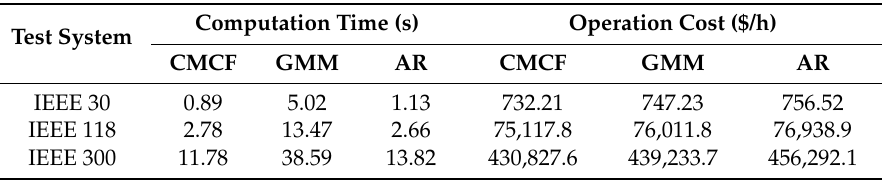
Table 7. Comparison among cumulants and cornish-fisher expansions (CMCF), gaussian mixture model (GMM) and analytical reformulation (AR) (1 − ε = 0.8).